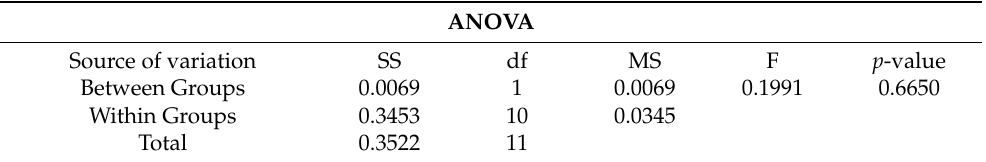
Table 2. Analysis of Variance (ANOVA) result of six Miscanthus genotypes (JPN-2011-010, PMS-7, PMS- 164, PMS-285, PMS-347, PI417947) between Hokkaido University screening experiment and Brigham Young University screening experiment using drought stress index of 21 days of SPAD value. ANOVA Source of variation SS